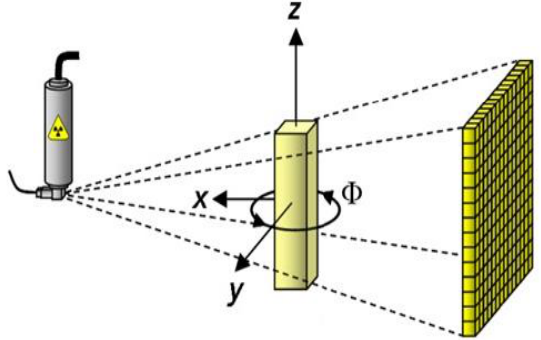
Figure 6. The schematic of the CT scan.